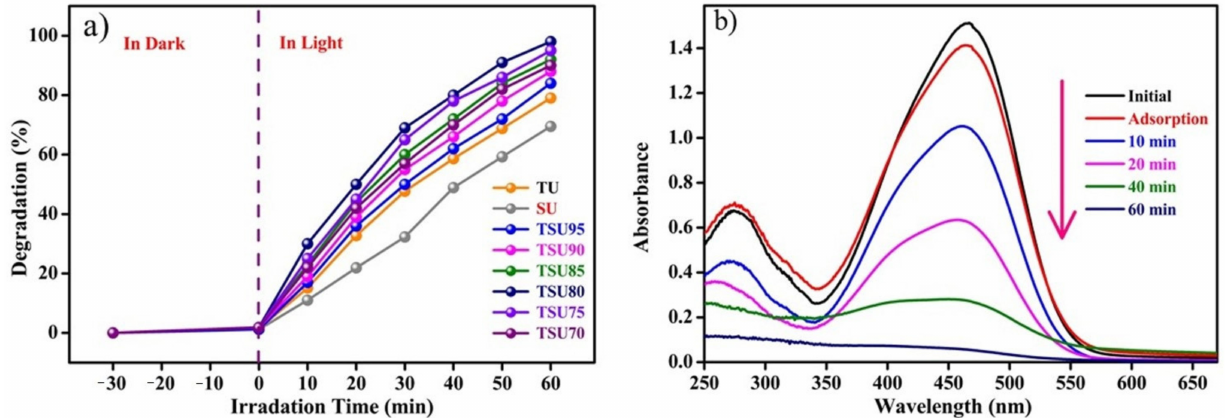
Figure 6. ( a ) Photocatalytic degradation of MO using different photocatalysts under UV-light irradia- tion ( b ) UV-Vis-absorbance spectra for the degradation of MO dye using TSU80